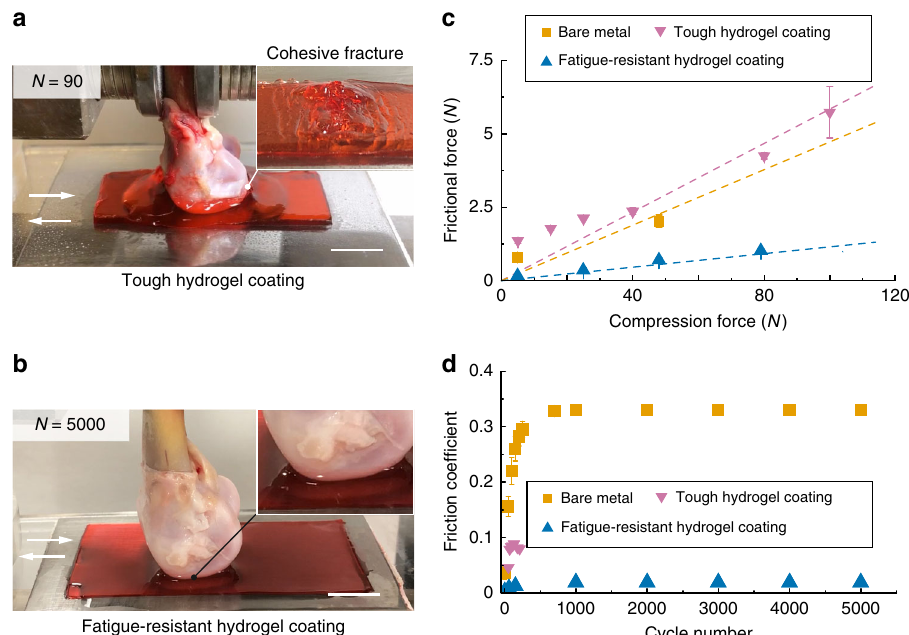
Fig. 6 Fatigue-resistant hydrogel coating on a stainless steel substrate and sliding against natural cartilages. a Image of tough hydrogel coating on stainless steel plate against cartilage, showing cohesive fracture at the 90th cycle of reciprocating sliding (compression force of 100 N). b Image of fatigue- resistant hydrogel coating on stainless steel plate against cartilage, showing robust adhesion after 5000 cycles of reciprocating sliding (compression force of 100 N). c Frictional force versus normal compression force for various substrates against cartilages at the fi rst cycle of reciprocating sliding ( N = 1). d Evolution of friction coef fi cient over 5000 cycles of reciprocating sliding for various substrates against cartilages with a normal compression force of 100 N (compressive stress of ∽ 1 MPa) for bare metal and fatigue-resistant hydrogel coating, or a normal compression force of 20 N (compressive stress of ∽ 0.2 MPa) for tough hydrogel coating. Error bars = standard deviation ( n = 3). Scale bars: 10 mm in ( a , b